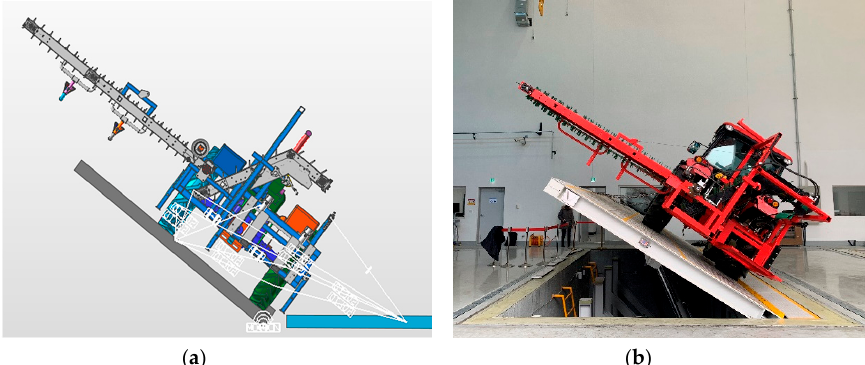
Figure 3. Lateral overturning stability: ( a ) simulation and ( b ) validation of the tractor–collector system at 0° folding position of the conveyor belt and without load.